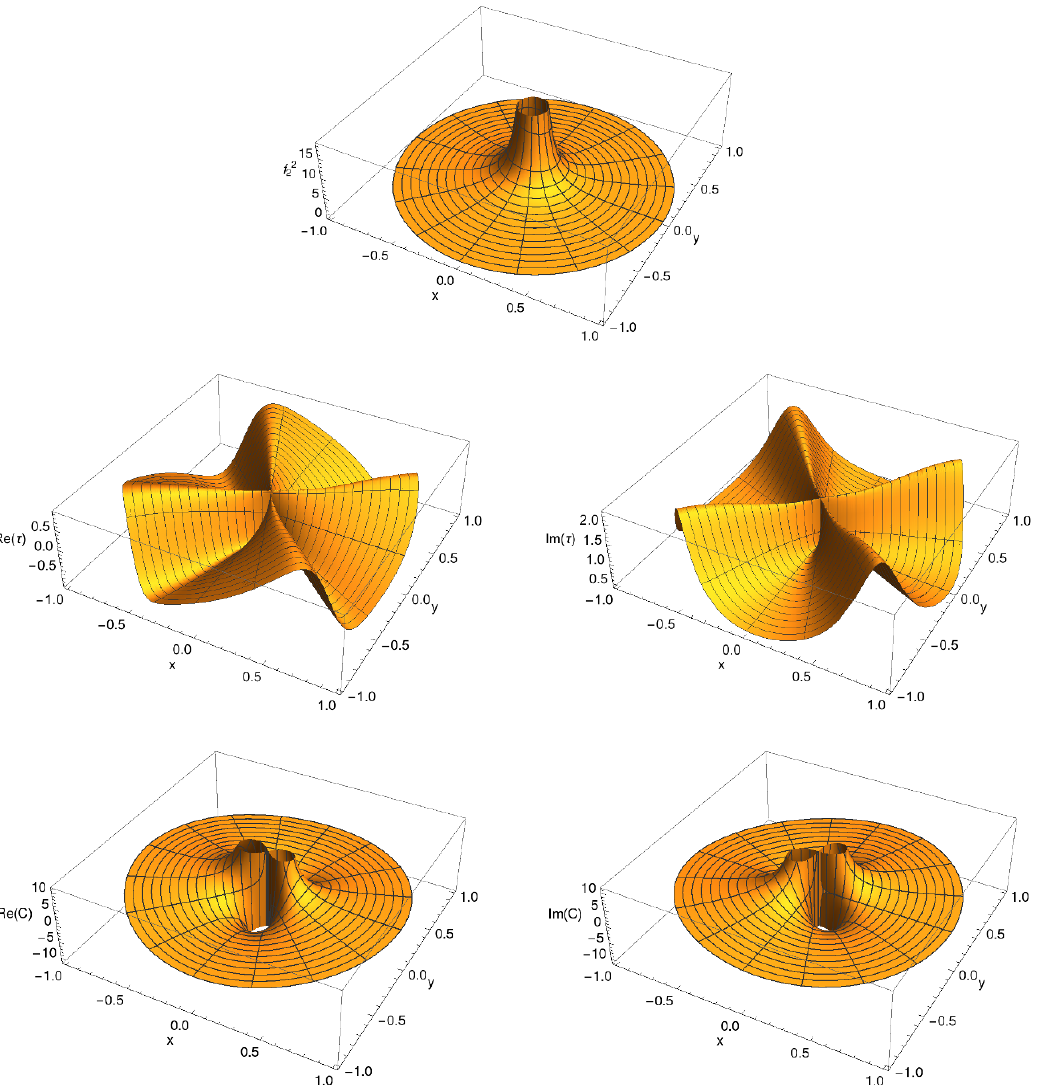
Figure 2 . The metric factors, axion-dilaton, and two-form (cid:12)elds for the solution with a single interior pole of order three. We have chosen A 0 metric factors all take the same qualitative form, we display only f 2